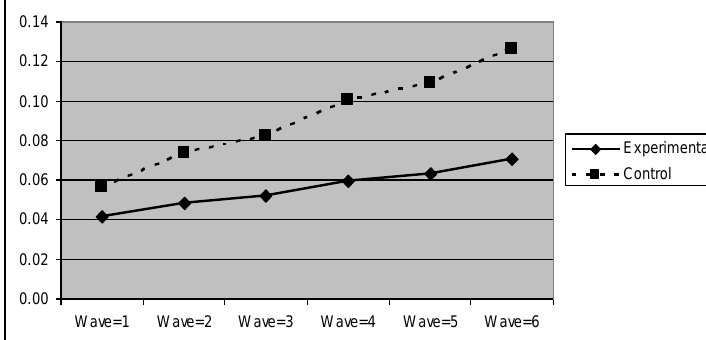
FIGURE 21 . Growth trajectories of the experimental group (Tier 1 participants who perceived the program as effective) and control group using the item score of ability to control the Internet as the outcome